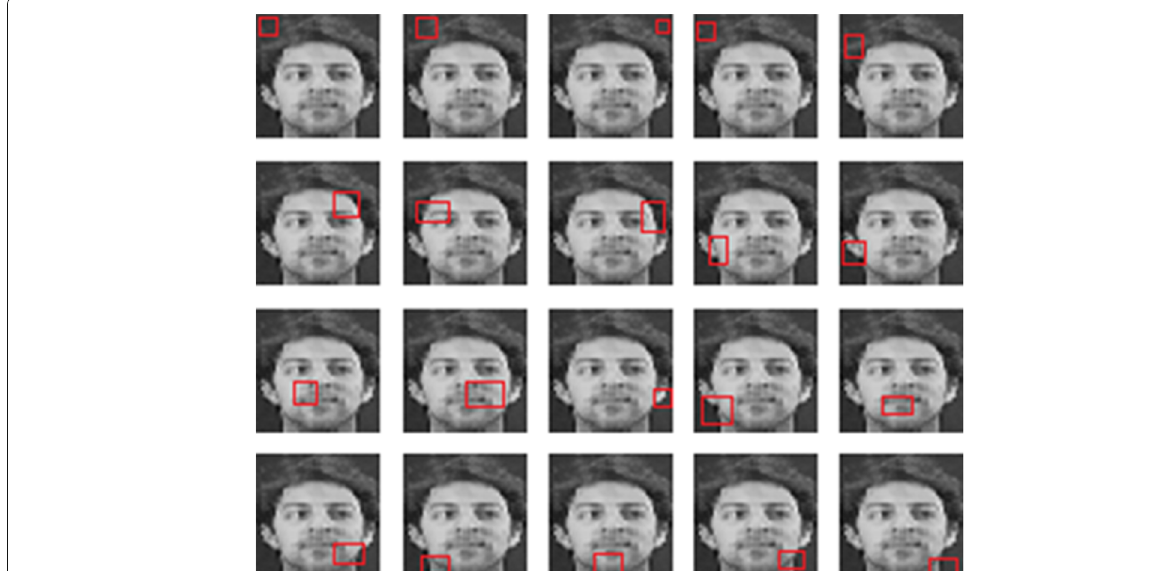
Fig. 6 Selected features